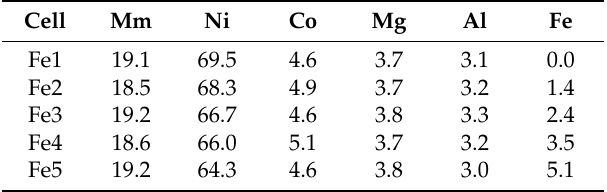
were used to the